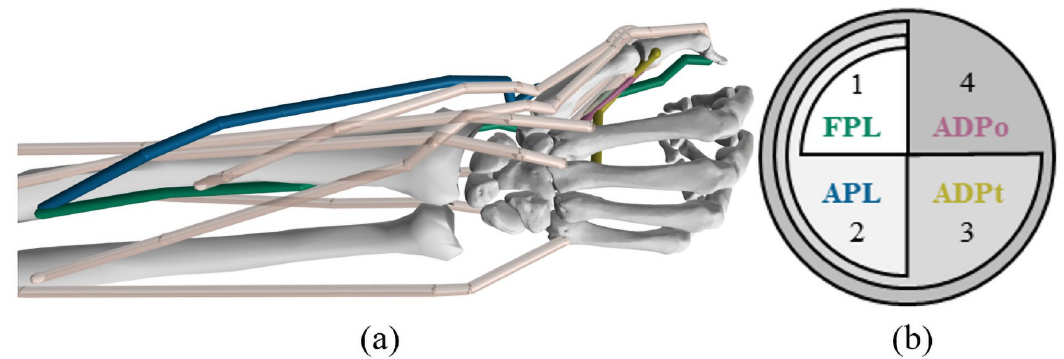
Fig 1. Musculoskeletal model and datasets. (a) Lateral pinch model used to generate dynamic thumb-tip force datasets [29]. (b) Values 1 through 4 correspond to Datasets 1 through 4, which varied the thumb muscle actuators shown. Datasets 1 through 4 contained 120, 1024, 2197, and 4096 simulations, respectively, representing different combinations of maximum isometric force values. For example, Dataset 1 included 120 variations to the FPL, while Dataset 4 included 8 variations to each the FPL, APL, ADPt, and ADPo.